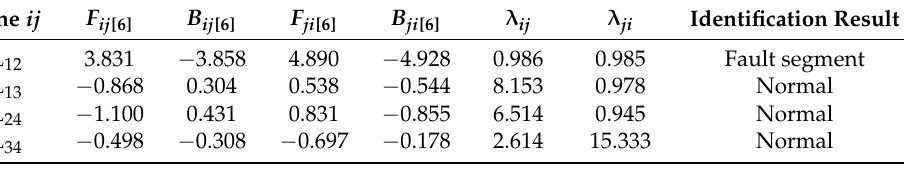
Table 1. Identification results of faulted segment for f 1 fault.